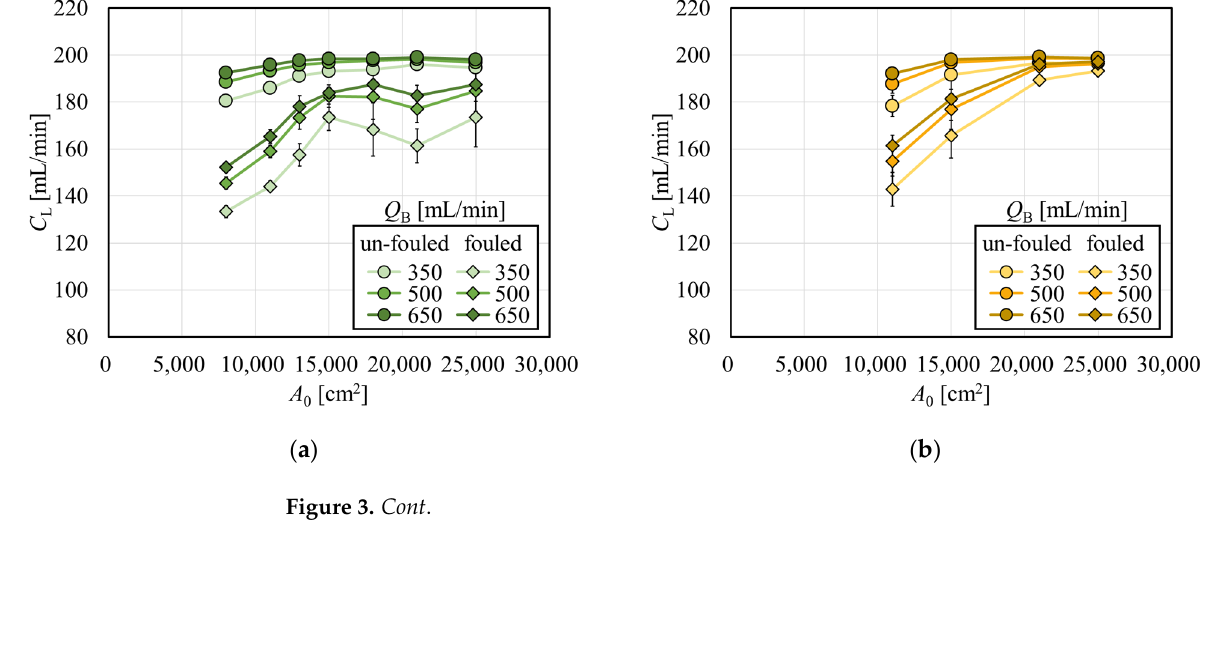
Figure 3. Effect of membrane fouling on the solute removal performance. ( a ) Creatinine clearances in APS-SA series with and without immobilization of albumin ( Q D = 500 mL/min, n = 3). ( b ) Creati- nine clearances in MFS-S eco series with and without immobilization of albumin ( Q D = 500 mL/min, n = 3). ( c ) Reduction rate of clearance in APS-SA series. ( d ) Reduction rate of clearance in MFX-S eco series. Figure 4. Relationship between A 0 and the packing density of the hollow fiber (PDF).